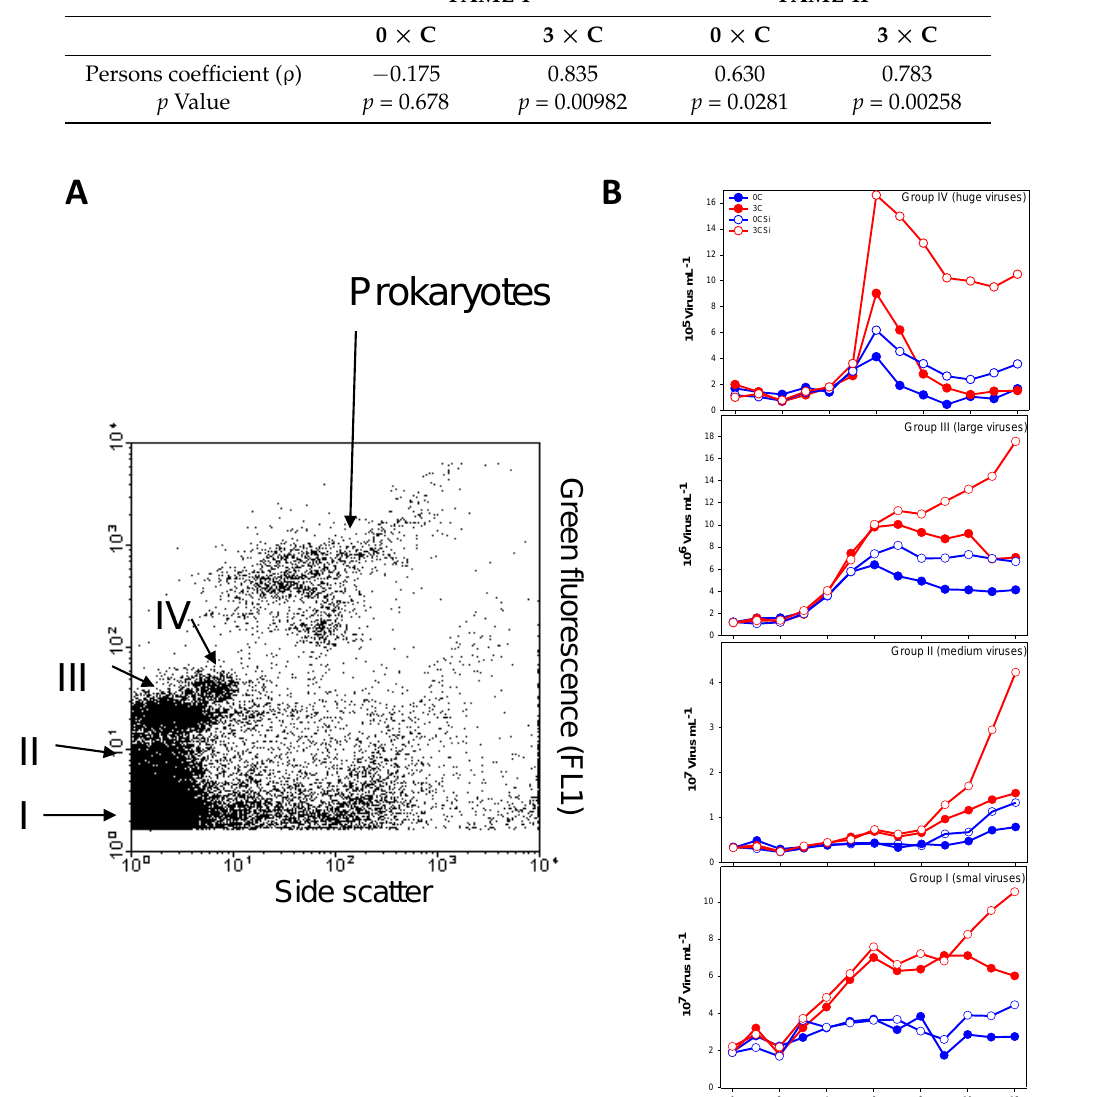
Figure 4. Biparametric flow cytrometry virus plots. Four different viral populations were discriminated combining side scatter signal vs. green fluorescent signal after staining with SYBR Green I (reflecting the amount of DNA and hence genome sizes): I, Small viruses, II, medium viruses, III, large viruses, IV, huge viruses ( A ) (see also Figure S2). Abundance of small (I), medium (II), large (III), and huge (IV) viruses determined by FCM in PAME-I ( B ). Blue circles show no addition of carbon in the form of glucose, while red circles show three Redfield additions of carbon. Open and filled circles display perturbations with or without silicate (open: no Si addition; filled: Si addition). See Figure 2 for more information about experimental